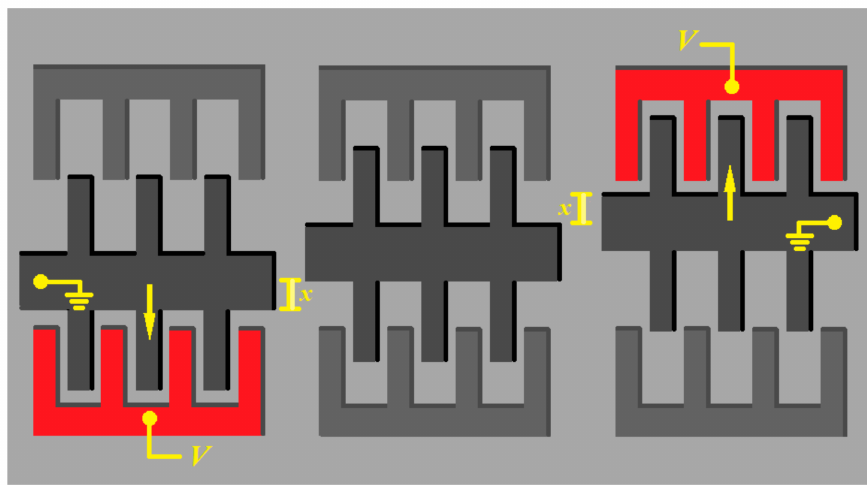
Figure 6. Depiction of the comb drive actuator where the movable electrode moves towards fixed electrode under voltage, shown in red.